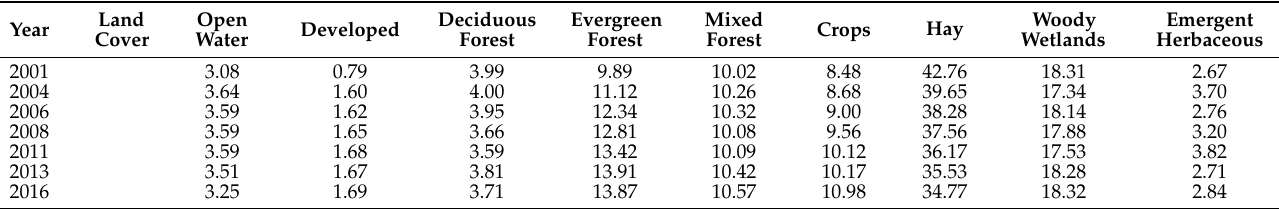
Table 2. Land use percentages from 2001 to